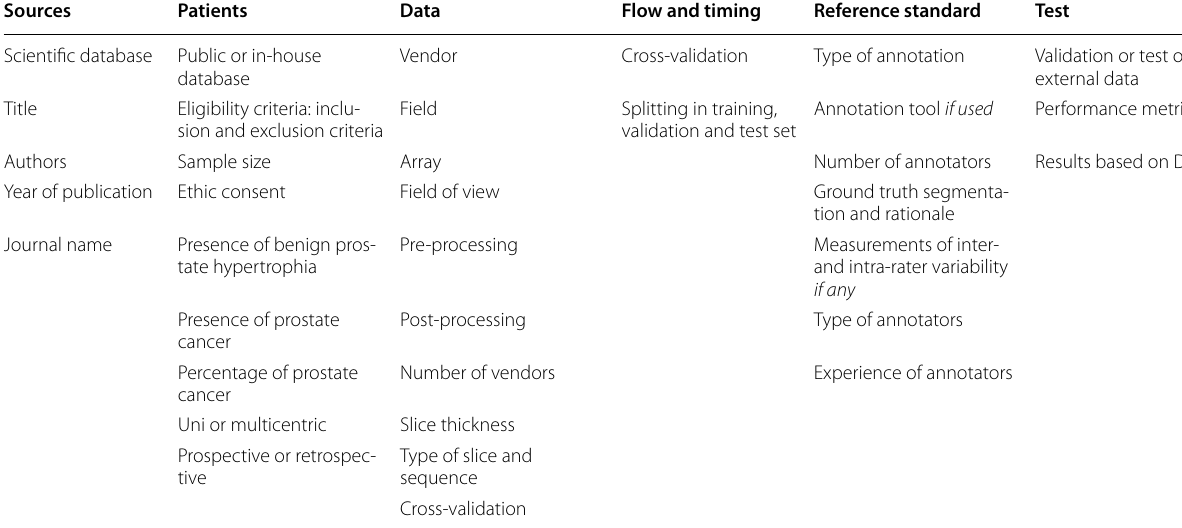
Table 1 Data extraction